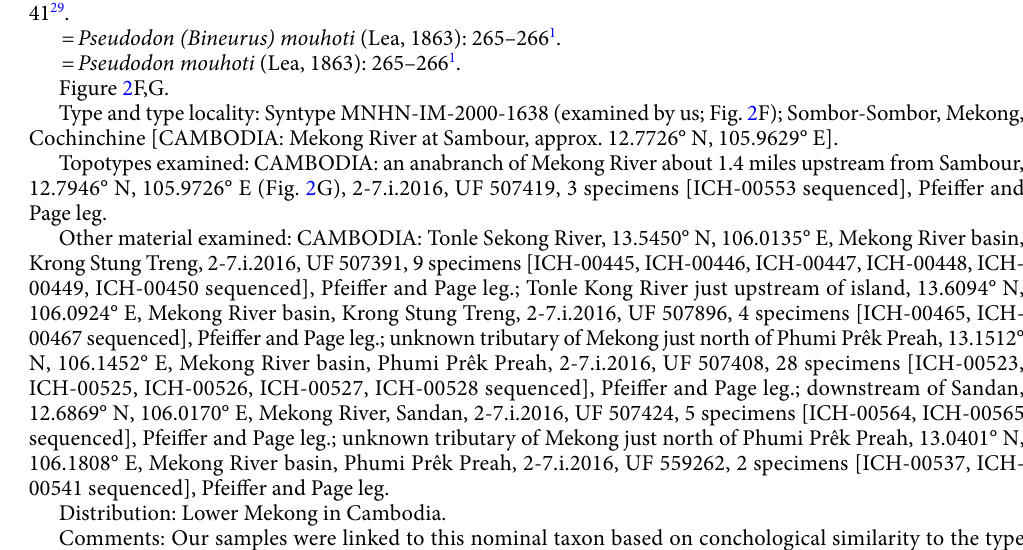
Figure 2F,G. Type and type locality: Syntype MNHN-IM-2000-1638 (examined by us; Fig. 2F); Sombor-Sombor,